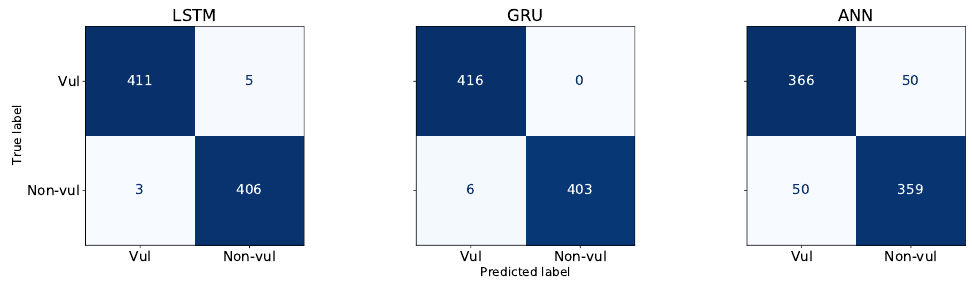
Figure 6. Confusion